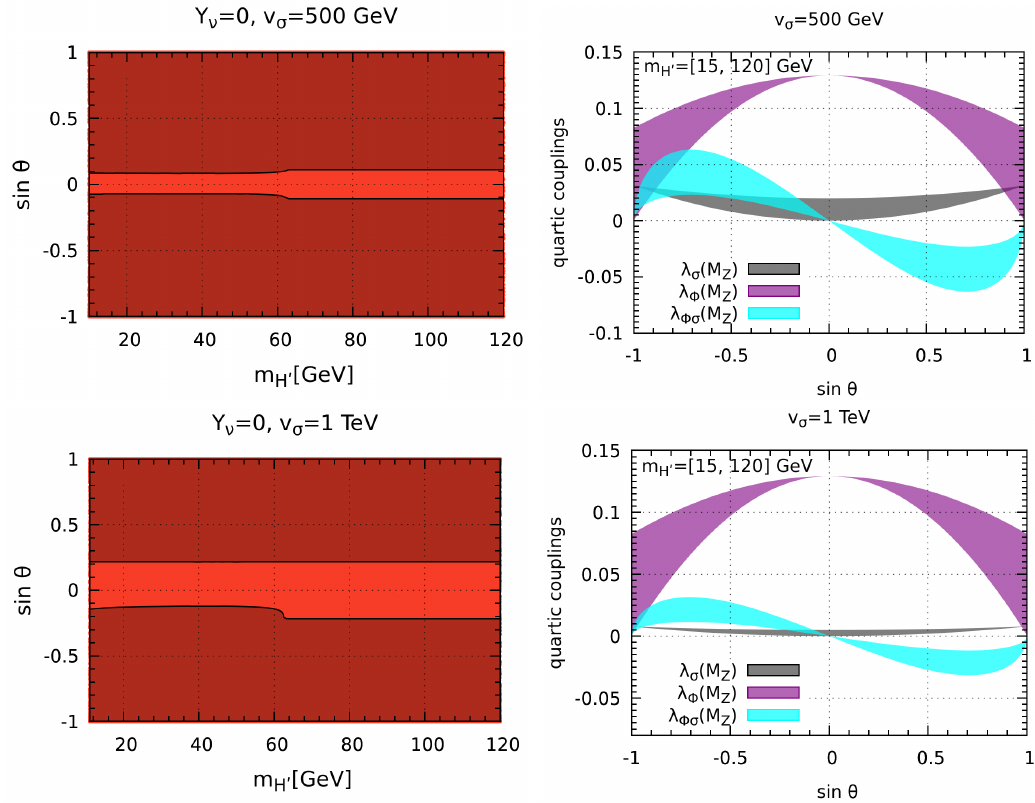
Figure 13 . Left panels: the nature of vacuum for the case of v σ = 500 GeV and 1 TeV, respectively, with Yukawa coupling Y = 0 . The color codes are same as in figure 12. ν Right panels: show the values of λ Φ , λ σ and λ Φ σ at the electroweak scale as a function of sin θ . The bands are due to variation of lighter Higgs mass m varation 15 GeV to 120 GeV. Note that the H 0 scale on the Y-axis of right panels is different compared to figure